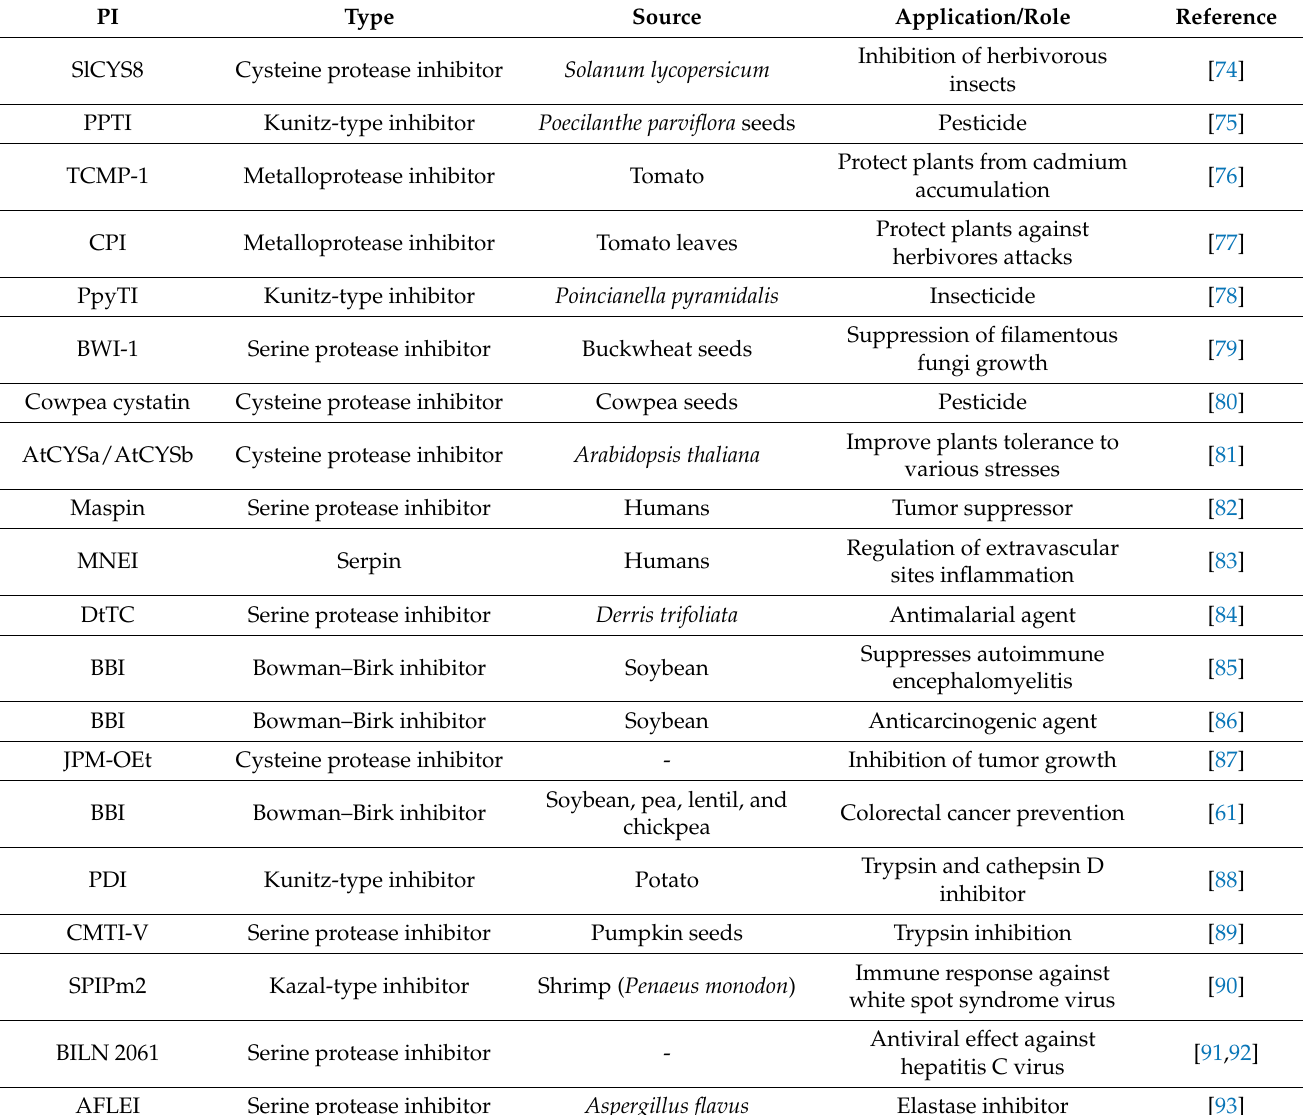
Table 1. Examples of protease inhibitors used in agriculture and